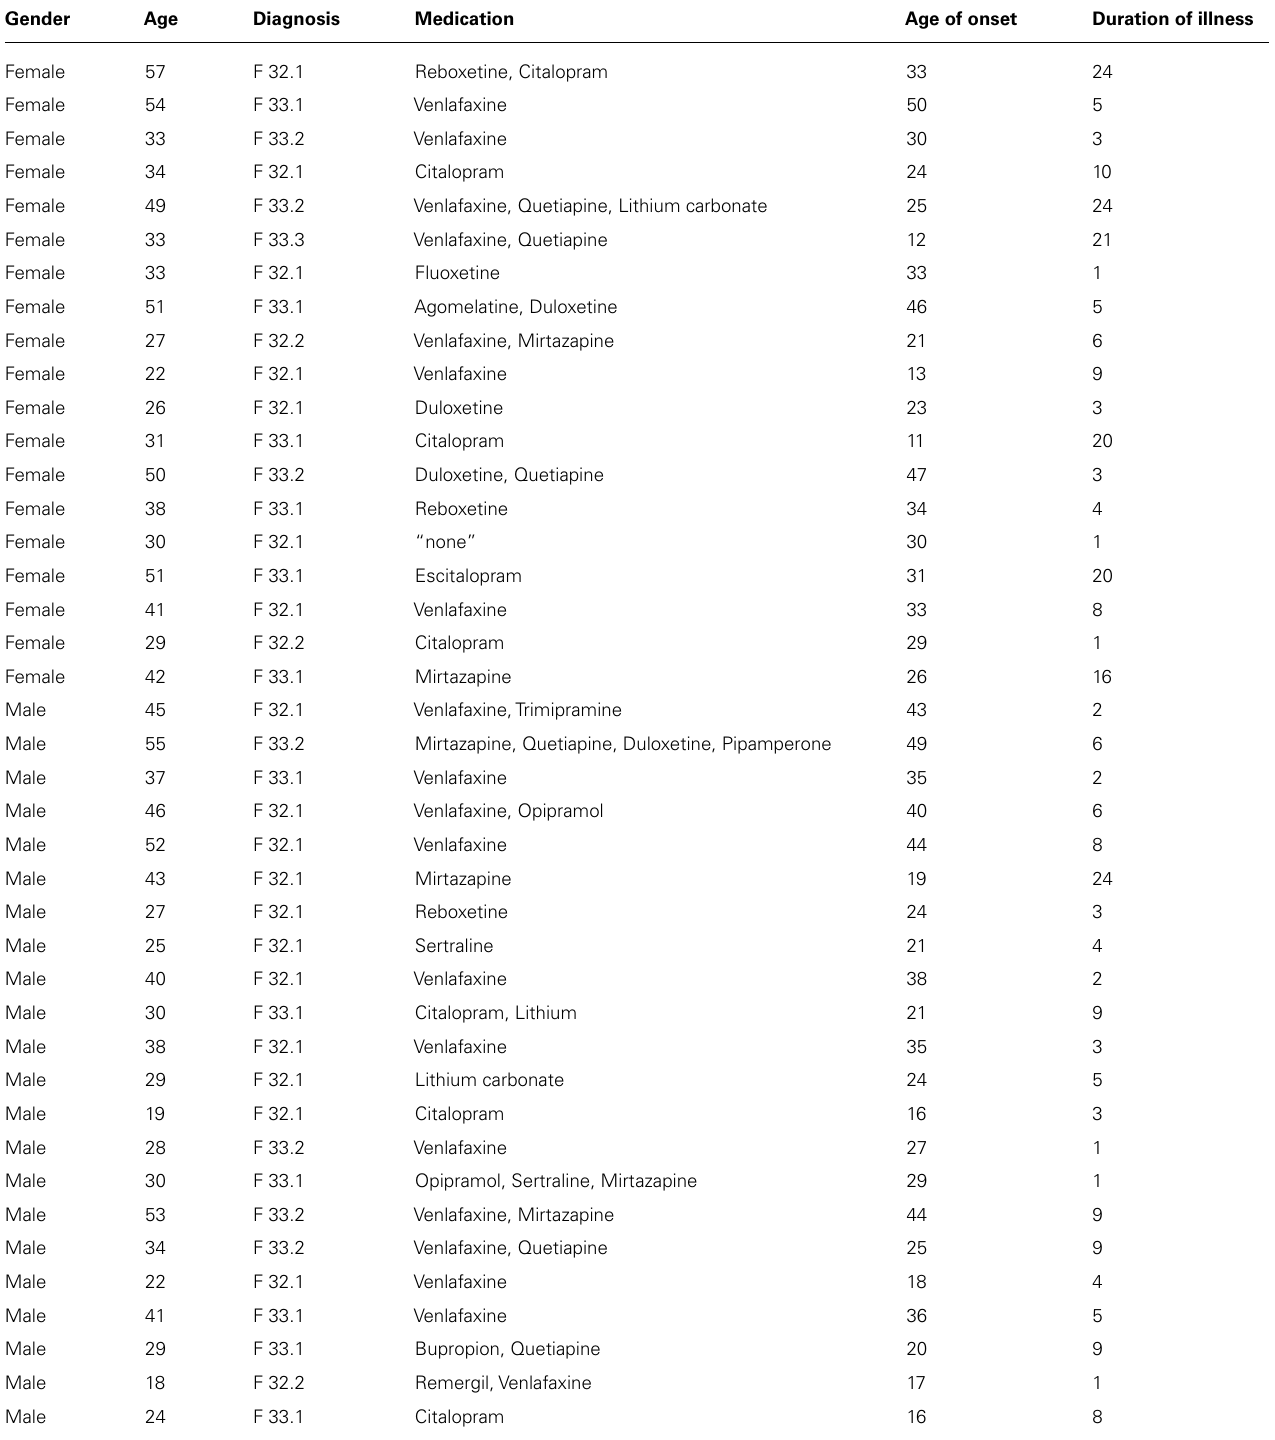
Table 2 | Patients’ demographic data and clinical